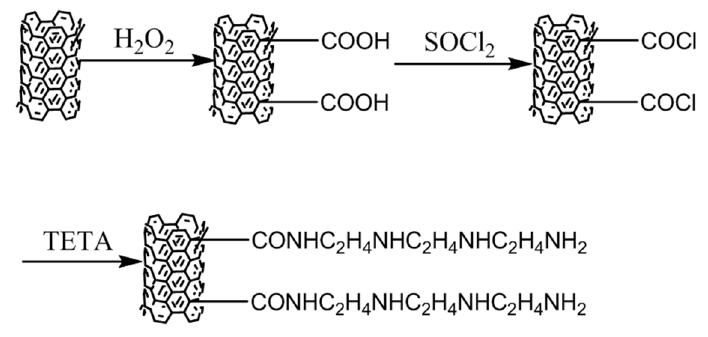
Figure 1. Schematic representation of the formation of amino ‐ MWCNTs.